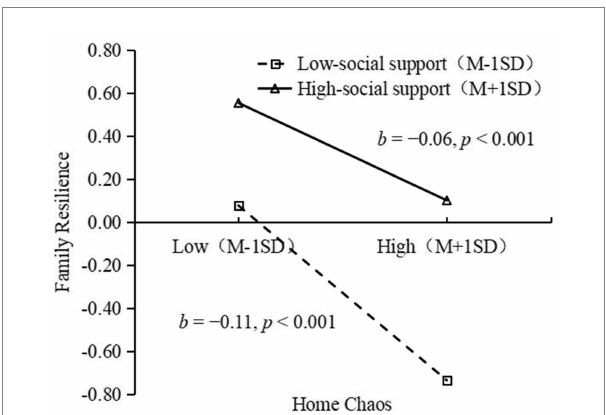
FIGURE 3 Relationship between home chaos and family resilience at different levels of social support. * p < 0.05, ** p < 0.01, and *** p <